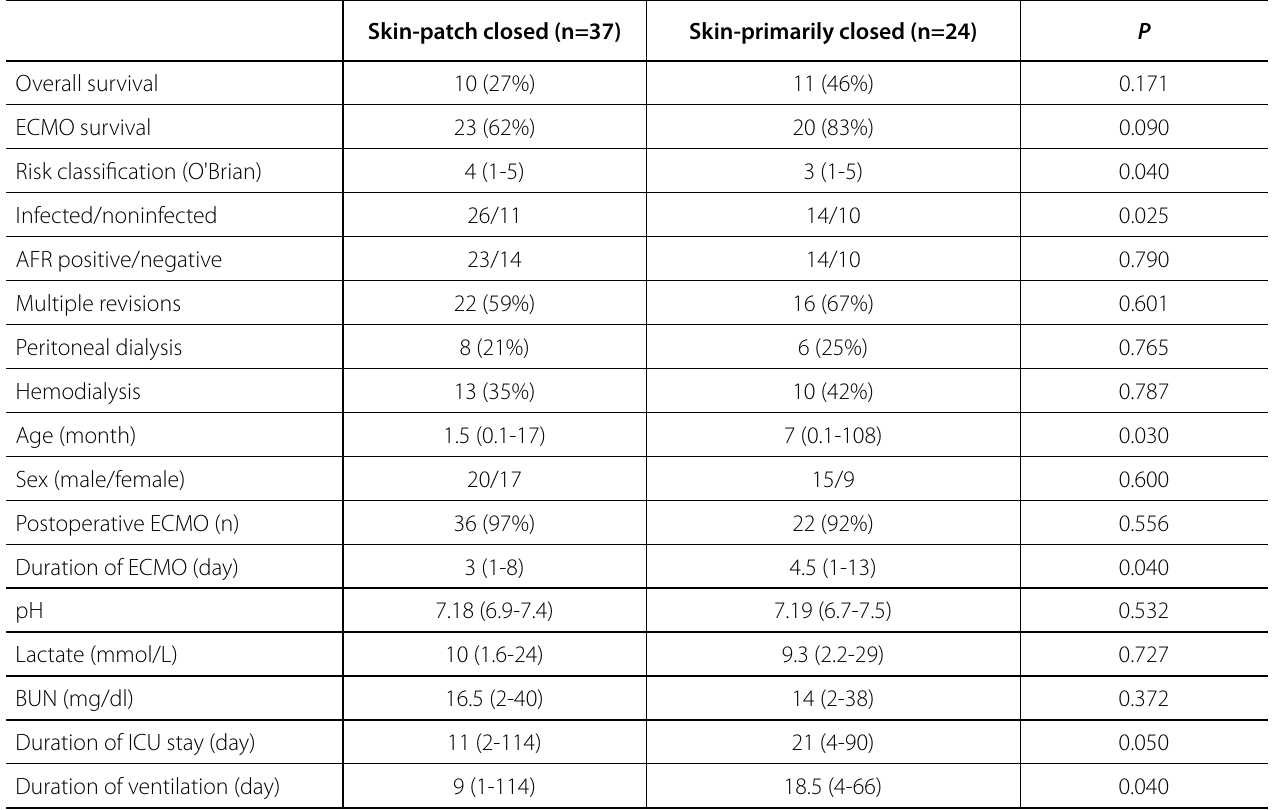
Table 3. Comparison of patient characteristics with skin patch-closed and primarily